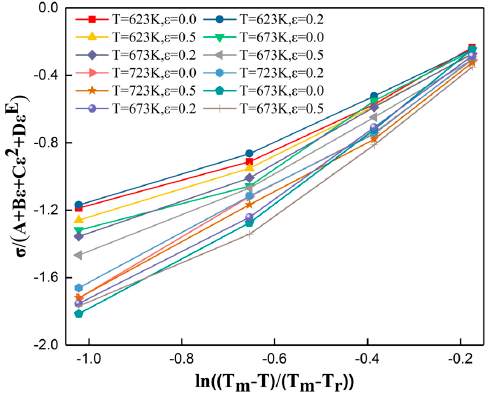
. ε * (cid:1)(cid:3) (cid:1)(cid:0) 1 + m 6 ln and